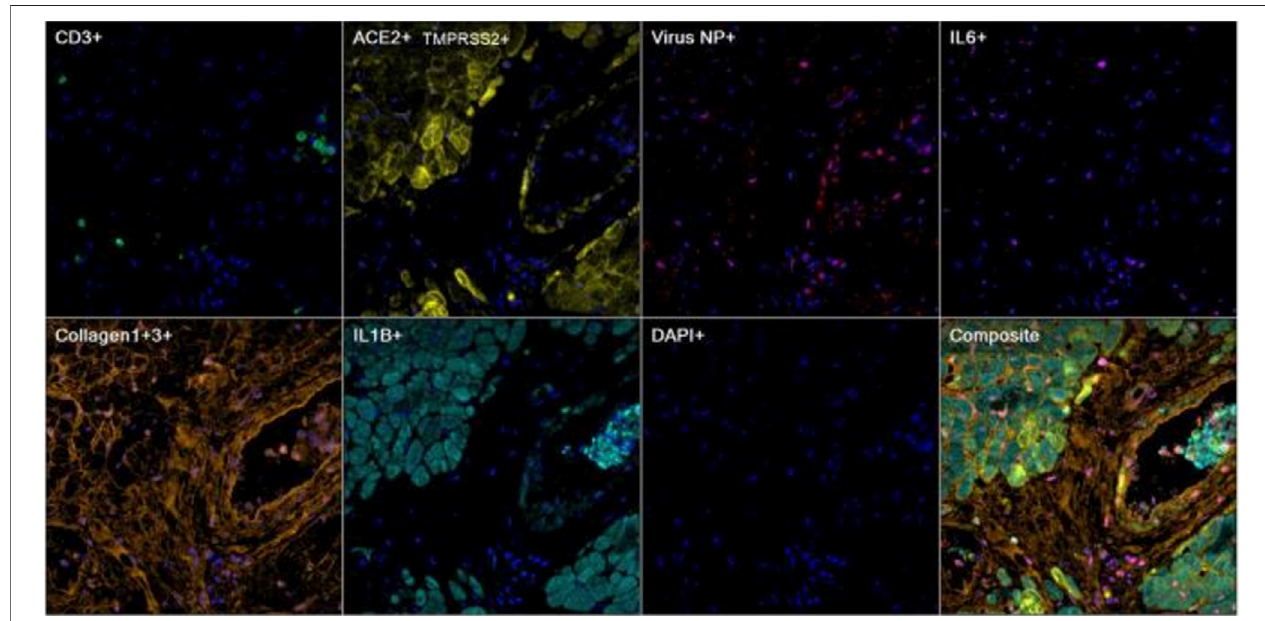
FIGURE 8 | Representative images of heart tissue stained using multiplex immunohistochemistry/immuno fl uorescence (mIHC/IF) [CD3 (green), ACE2/TMPRSS2 (yellow), Virus NP (red), IL6 (magenta), Collagen1+3 (orange), IL1B (cyan), DAPI (blue)] (Magni fi cation, 400X).